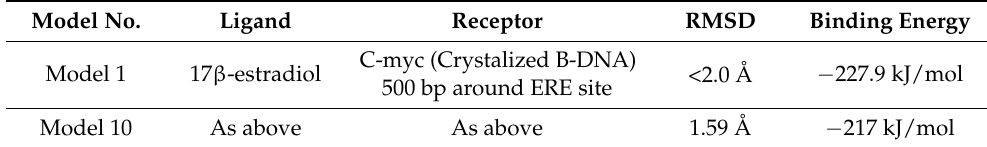
Table 3. Binding energies and RMSD of Model 2 and 10.